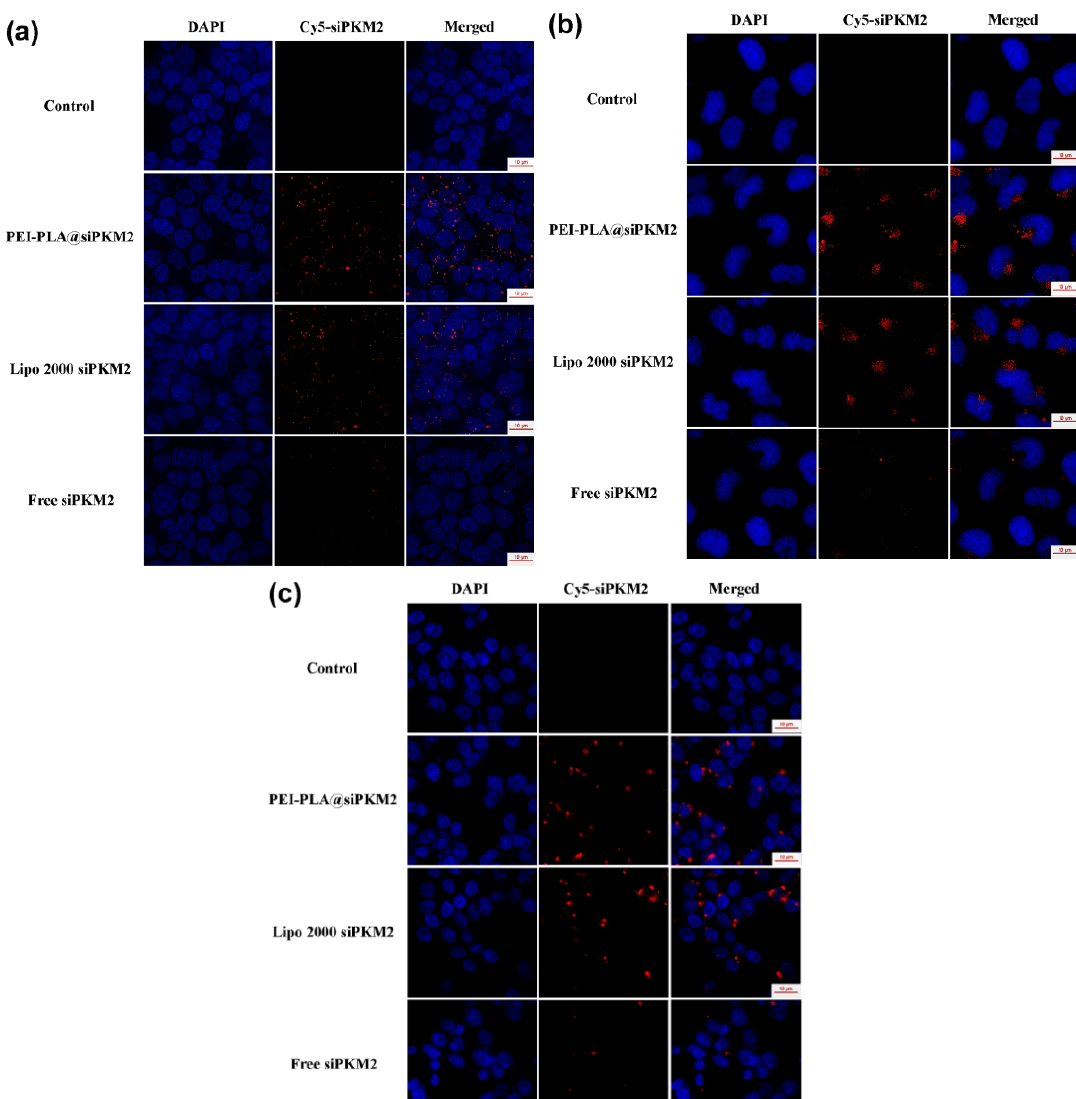
Figure 6. Representative images of of ( a ) HCT116, ( b ) HepG2 and ( c ) SKOV3 cells after transfection with PEI-PLA@siPKM2 polyplex, Lipo 2000 and free siPKM2 for 12 h. Cy5-labled siPKM2 was used in this experiment for visualization of cellular uptake and the nuclei were stained with DAPI.